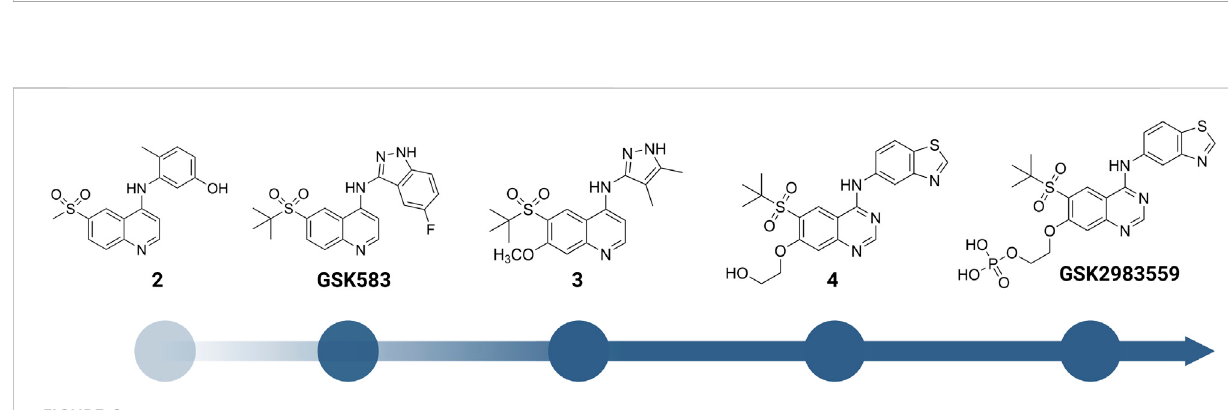
Co-crystal structure of 1 and RIPK2 (PDB ID: 5AR5). Ligand-receptor H-bonds are indicated by dashed lines. The DFG motif is shown in green.